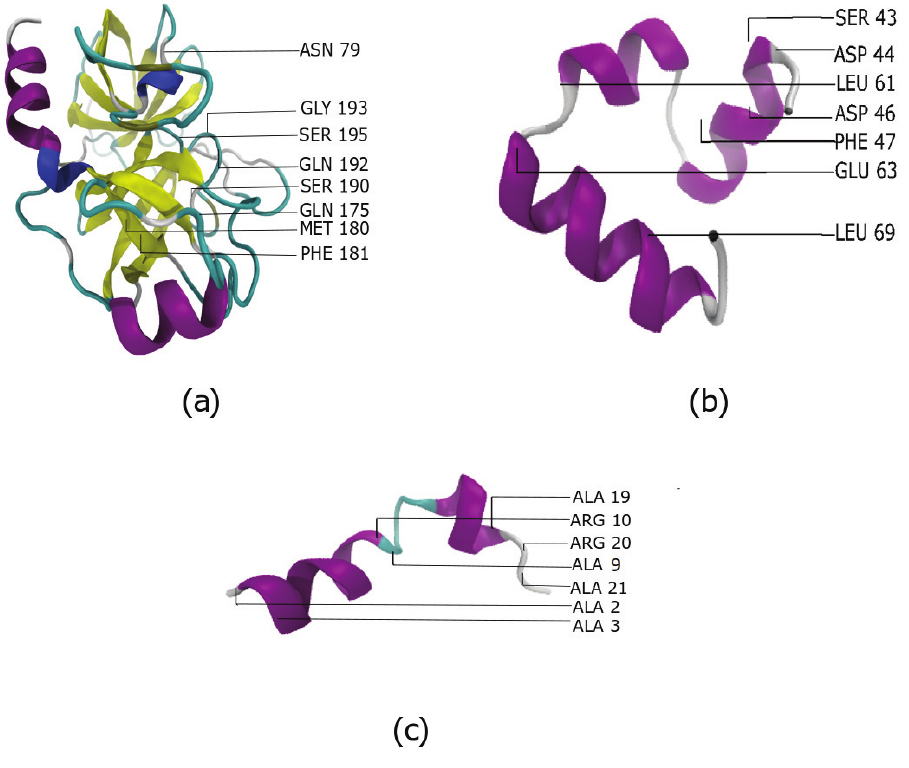
Figure 3 The most important features identified by our approach for three systems (A) Benzamidine - Trypsin (B) Villin and (C) Fs Peptide. Full-size DOI: